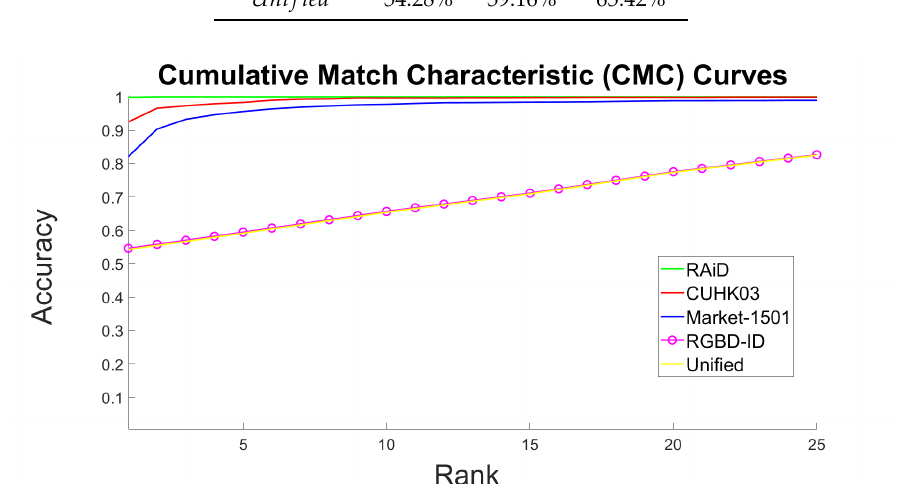
Figure 9. Cumulative Match Characteristic ( CMC ) curves per dataset as achieved by the Inception V3